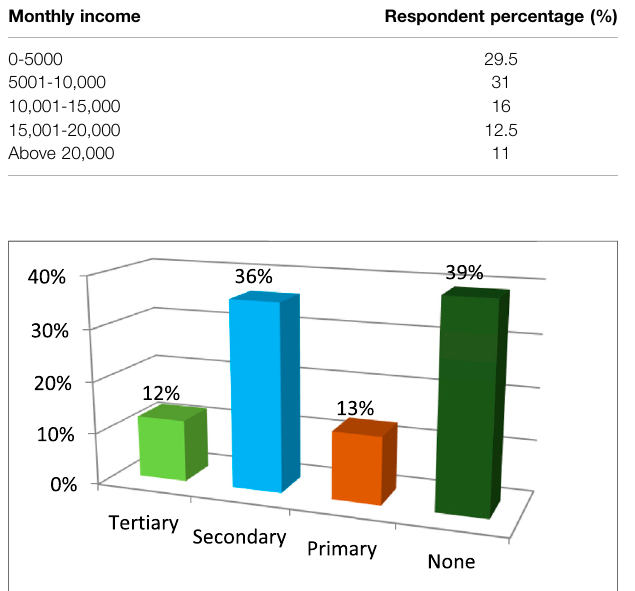
FIGURE 4 | Highest educational level obtained by respondents.